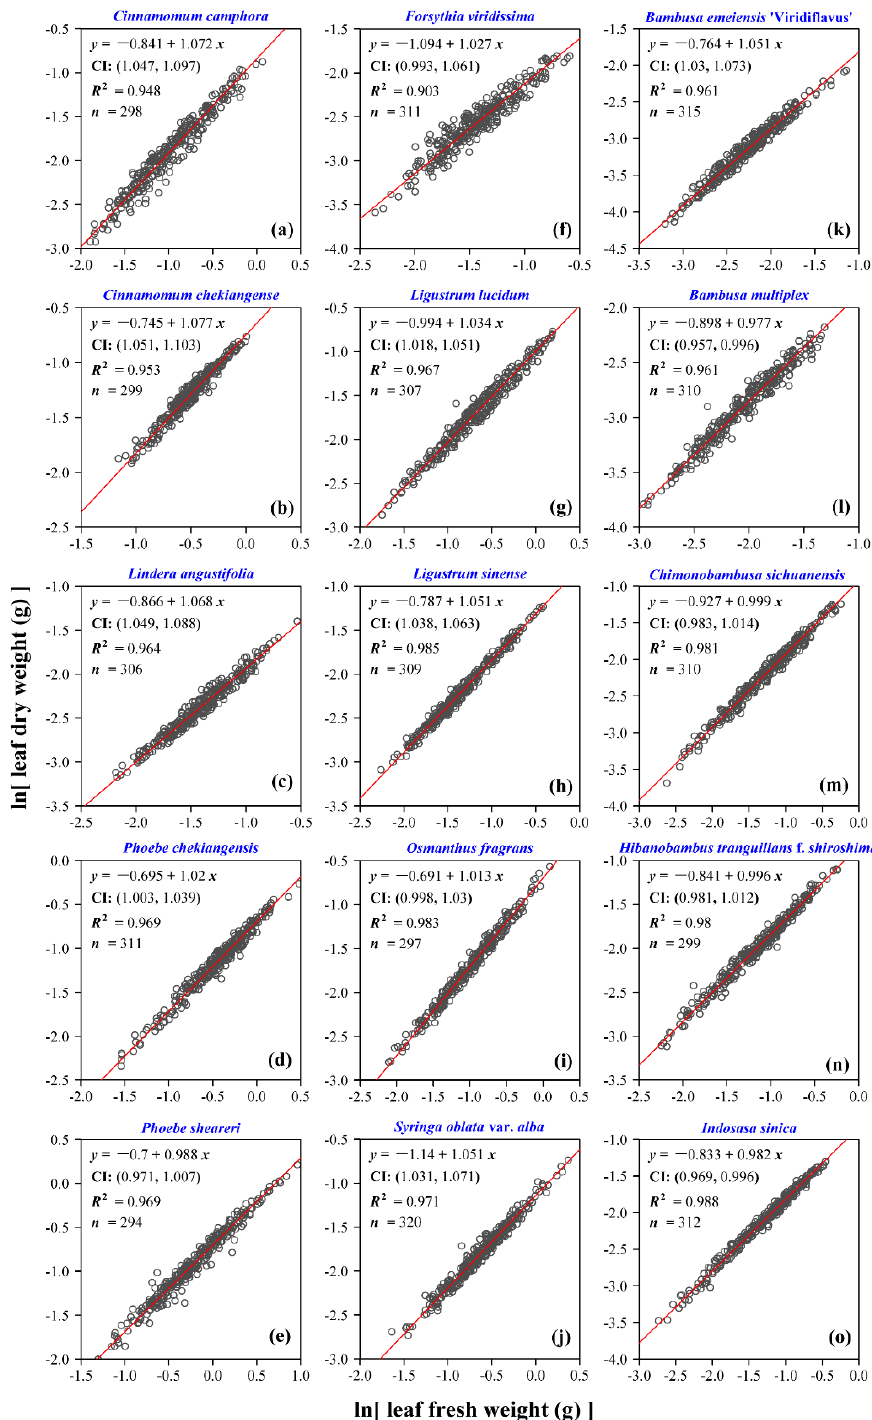
Figure 2. Scaling relationship of leaf dry weight to fresh weight at individual species level. Panels ( a – e ) belong to Lauraceae, panels ( f – j ) belong to Oleaceae, and panels ( k – o ) belong to Bambusoideae. In each panel, the open circles represent the observations, and the red straight line represents the reduced major axis regression line. Furthermore, y represents the natural logarithm of leaf dry weight in g, x represents the natural logarithm of leaf fresh weight in g, CI represents the 95% confidence interval of the slope, R 2 is the coefficient of determination used to measure the goodness of fit, and n represents the number of leaves sampled.